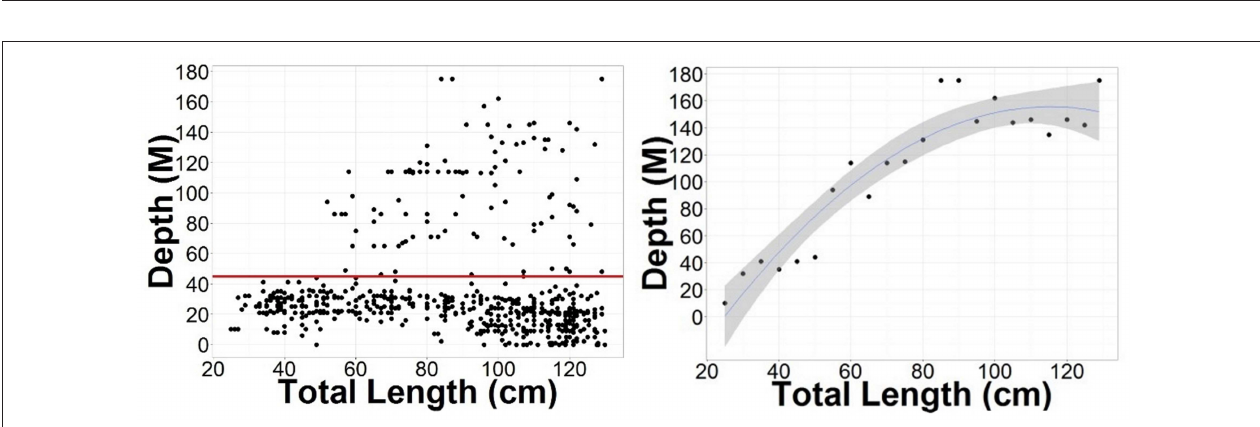
FIGURE 2 | Distribution of all immature tope (max length = 130cm) based on mark and recapture and International Bottom Trawl Survey (IBTS) data sets. Color represents smallest sized (based on total length) animal predicted to occur in that area. Smoothing was performed using kriging methods on minimum total length at each site using ArcGIS 10.2.